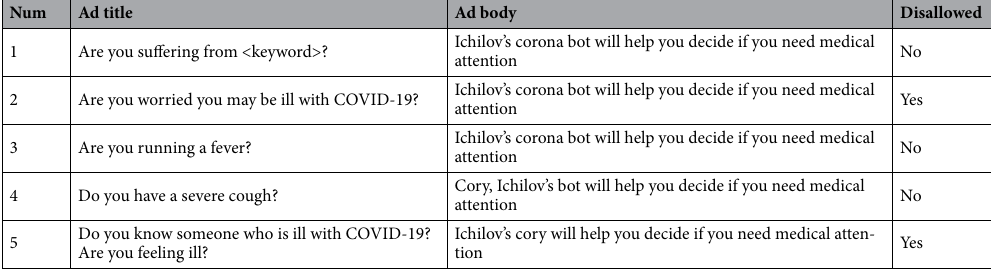
Table 1. Advertisement text. The token <keyword> refers to the keyword which caused the ad to be shown. Ichilov is the colloquial name of the Tel Aviv Sourasky Medical Center. Disallowed ads were not permitted by the ad